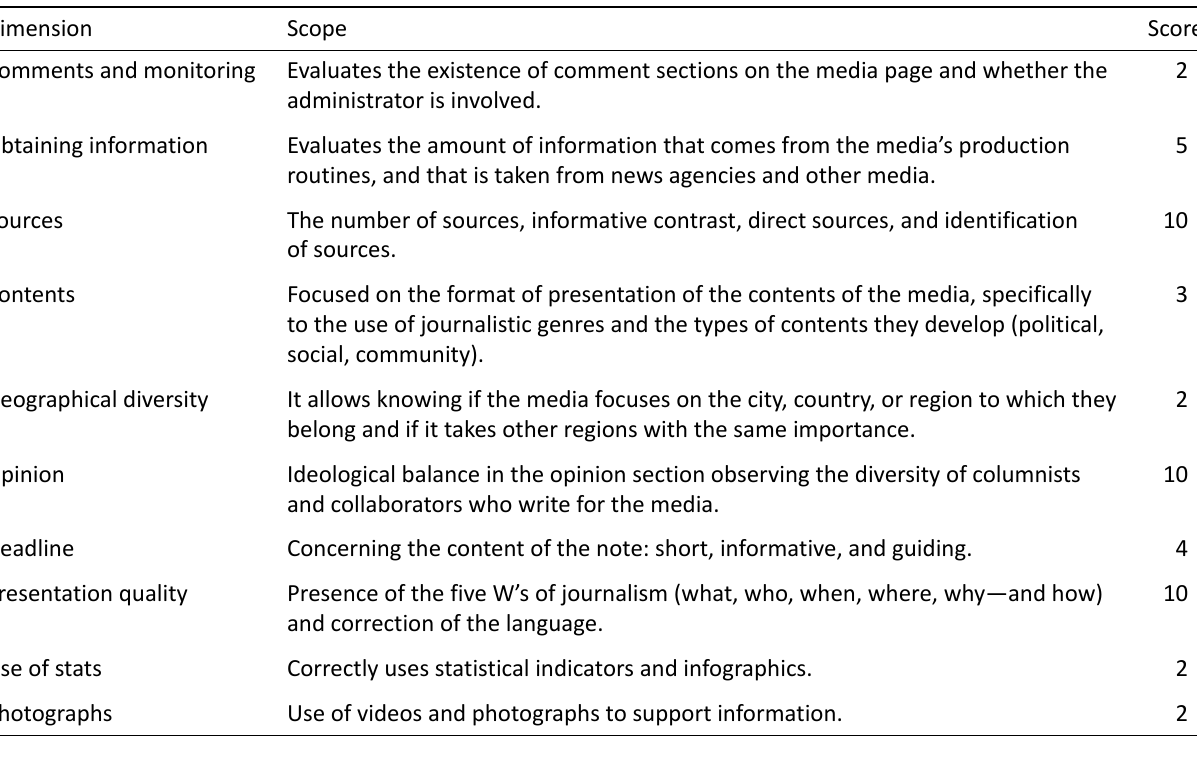
Table 2. Dimensions and assessment of the informational quality of digital media content.